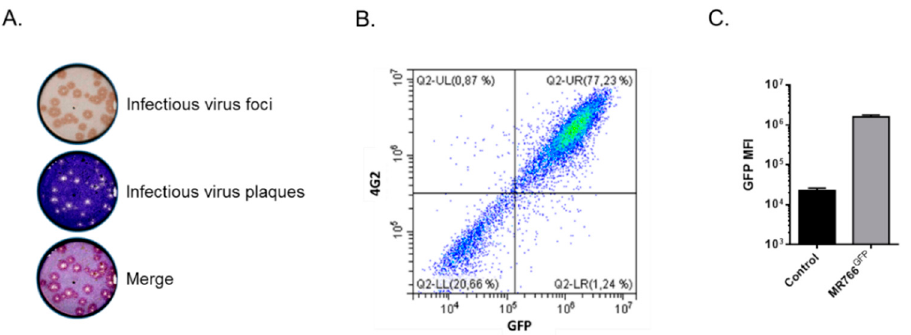
Figure 1. Characterization of viral clone MR766 GFP on Vero cells. In ( A ), the example of infectious virus foci developed after a focus-forming assay using anti-GFP antibody. To visualize infectious virus plaques, the cell monolayer was counterstained with crystal violet. In ( B ), cells were infected 24 h with MR766 GFP at an m.o.i. of 1. The GFP-positive cells (GFP) stained with anti-E MAb 4G2 (4G2) were analyzed by flow cytometry analysis. In ( C ), mean fluorescent intensity (MFI) of MR766 GFP -infected cells (MR766 GFP ), as determined by flow cytometry analysis. Control: mock-infected Vero cells.